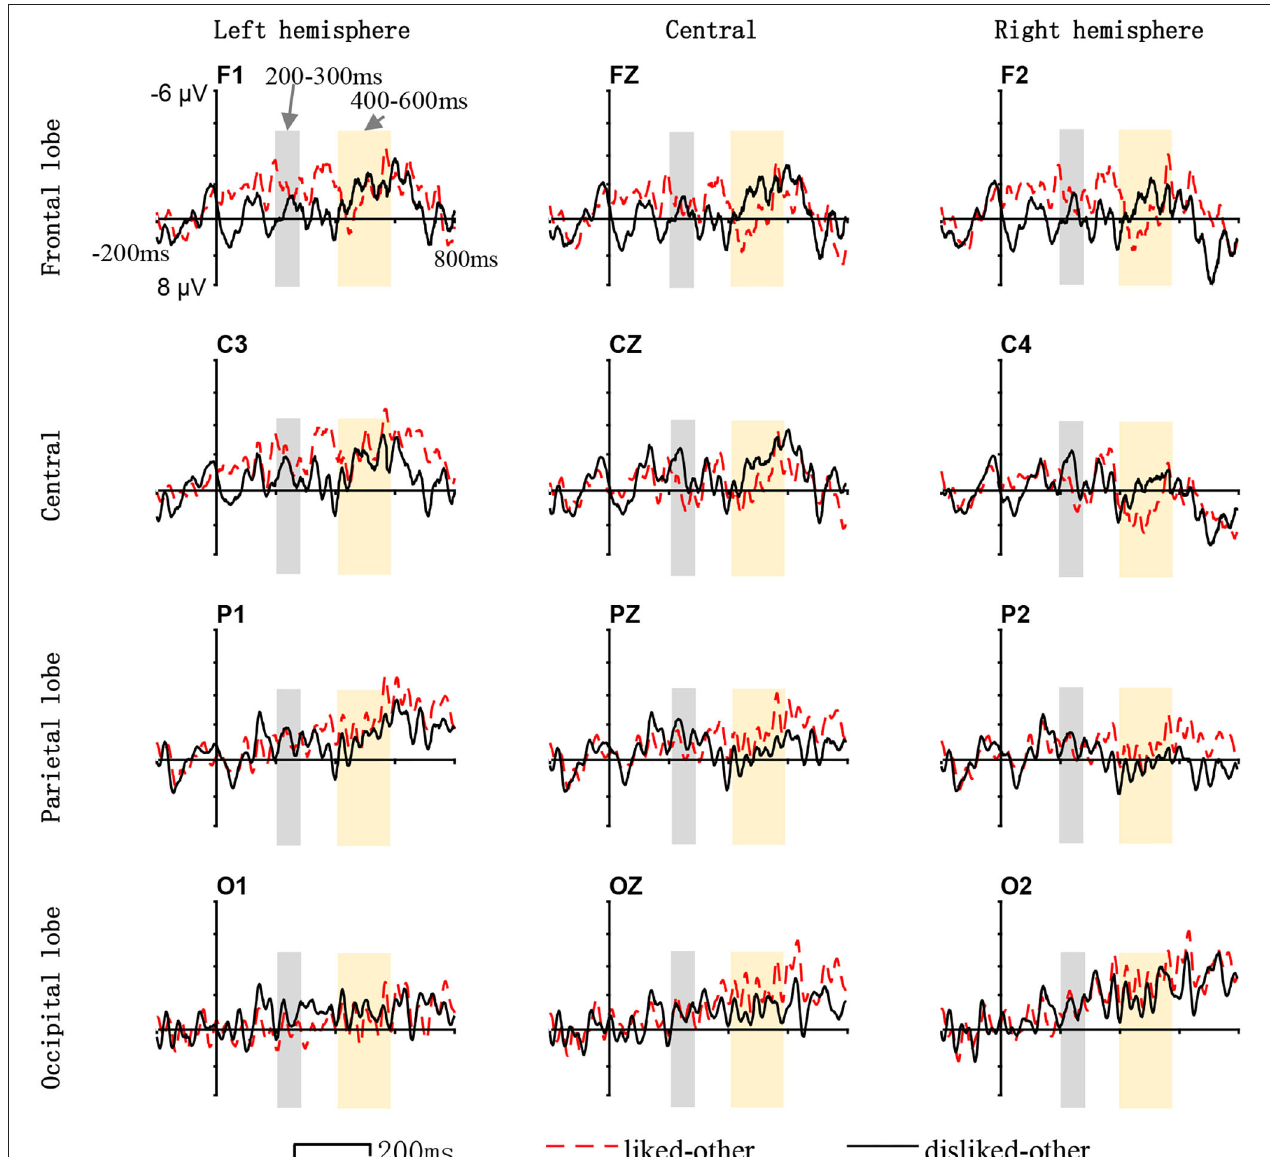
FIGURE 5 | Difference ERP waveforms of comparing waveforms of liked/disliked/other stimuli. The waveforms were constructed by using (1) the grand average ERP waveforms for the liked interfaces against that of the other interfaces and (2) the grand average ERP waveforms for the disliked interfaces against that of the other interfaces, for each electrode site. The x-axis indicates the time and the y-axis indicates the voltage. The gray mark indicates the 200–300 ms time window, the light yellow mark indicates the 400–600 ms time